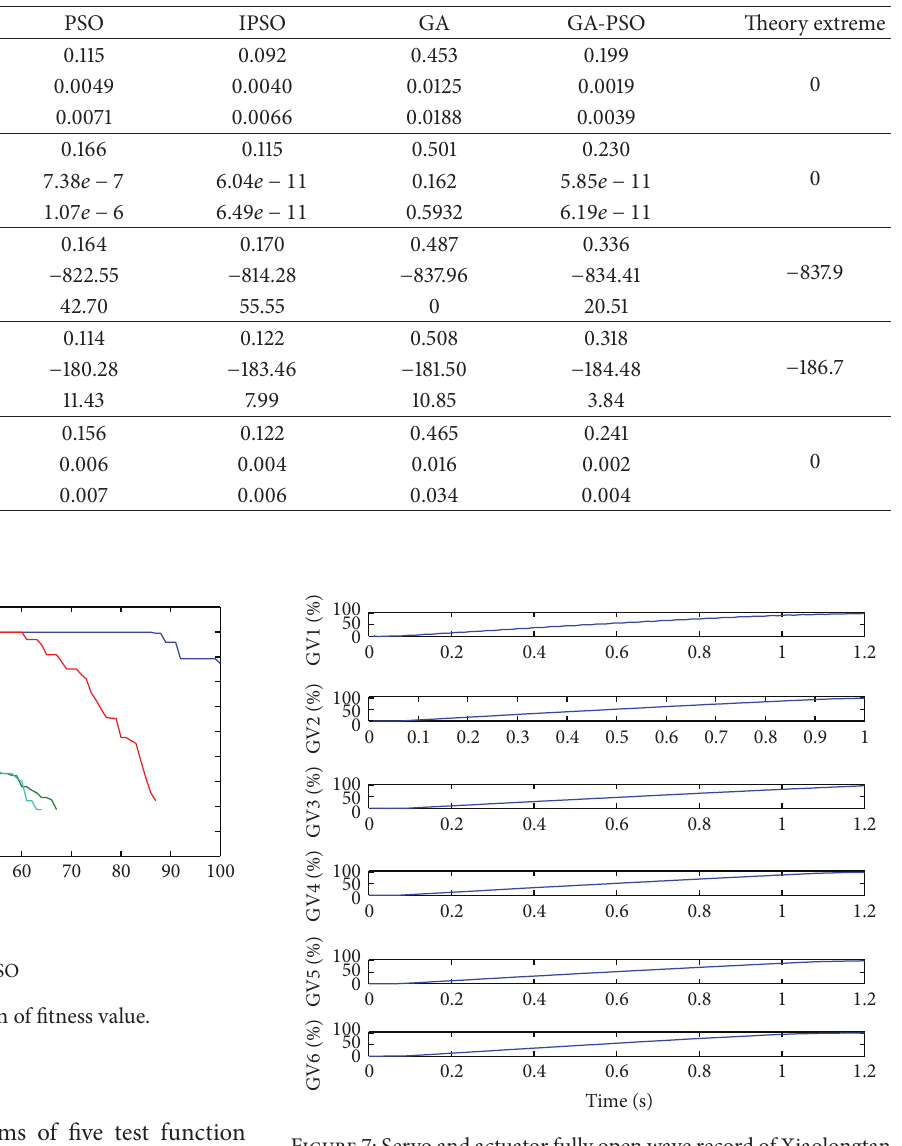
Table 1: The average running time, average optimal value, and standard deviation of the four algorithms.